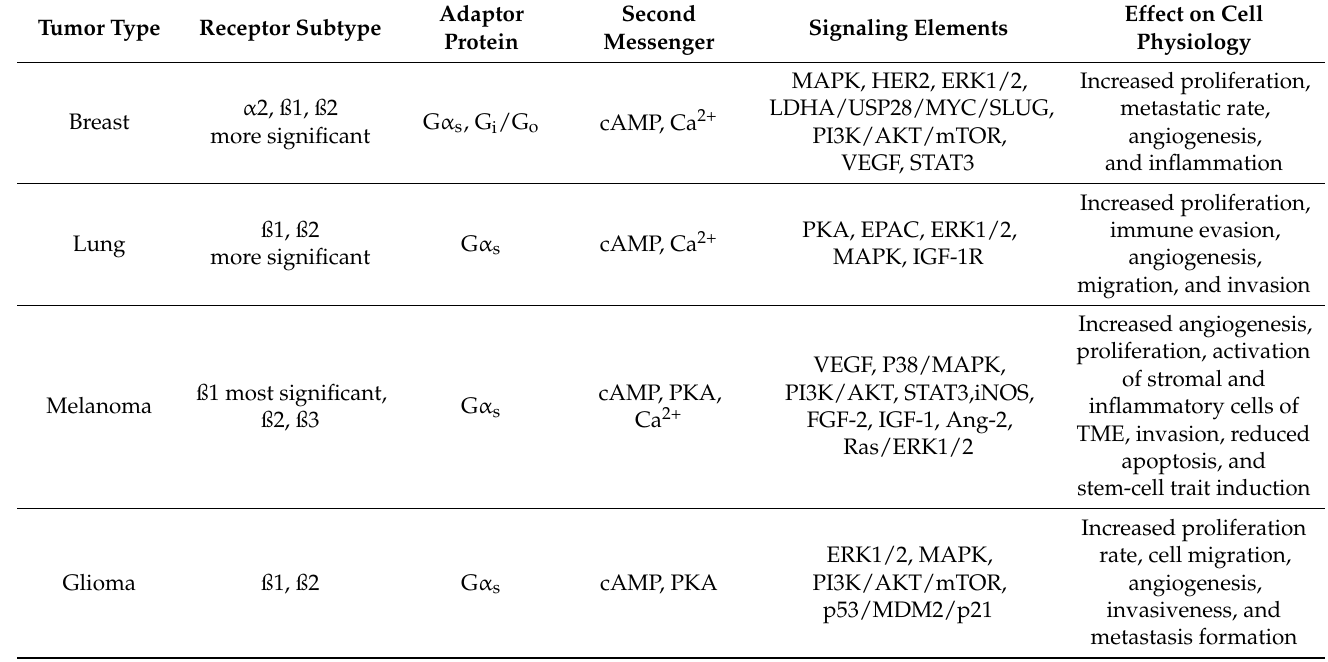
Table 1. Elements of the adrenergic signaling pathways in different tumor types. (Abbreviations: HER2, human epidermal growth factor 2; VEGF, vascular endothelial growth factor; STAT3, signal transducer and activator of transcription 3; FGF-2, fibroblast growth factor 2; Ang-2, angioprotein-2; MDM2, mouse double minute 2 homolog/E3 ubiquitin-protein ligase; LDHA, lactate dehydrogenase A; USP28, ubiquitin-specific peptidase 28; SNAI2/SLUG, snail family transcriptional repressor 2; iNOS, inducible nitric oxide